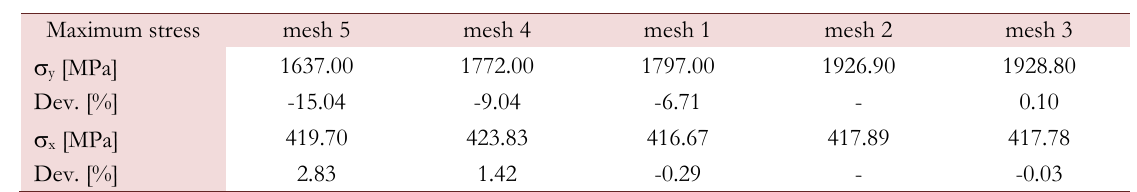
=5443.5N, a=10mm, ρ * =55µm). max